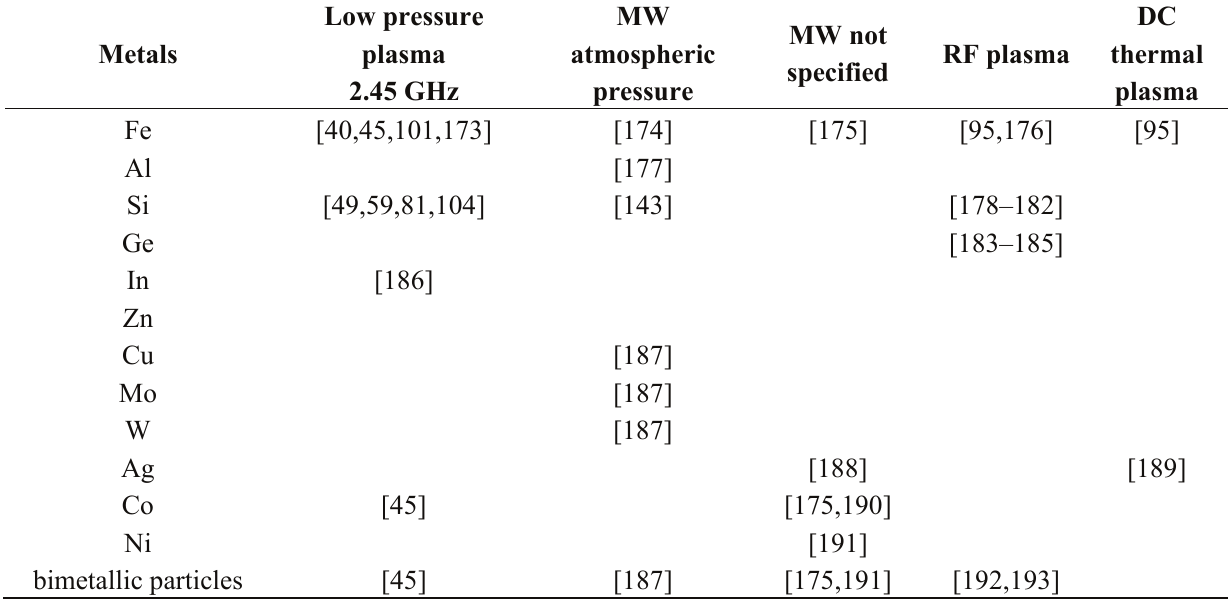
Table 5. Overview on published papers related to the subject of metal nanoparticles, synthesized in microwave plasmas.